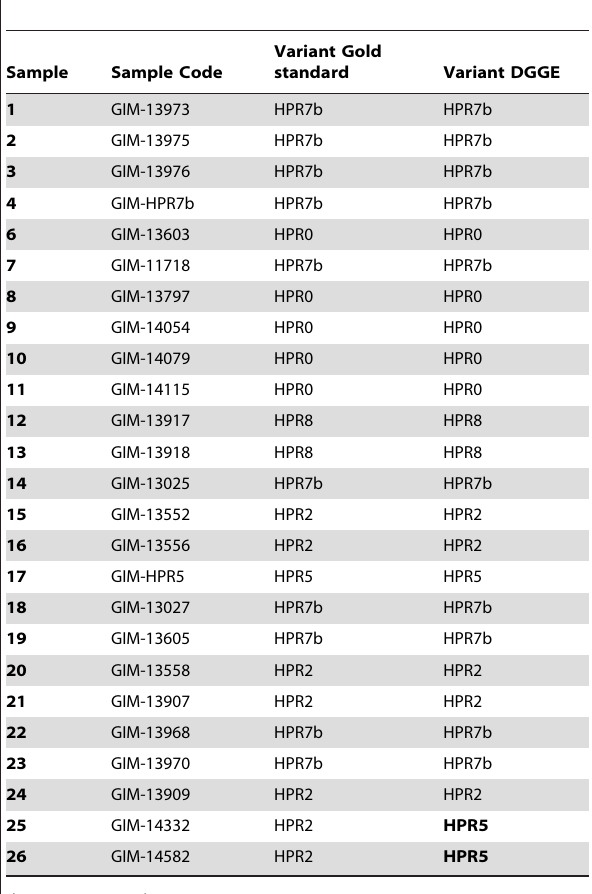
Table 2. Field samples analyzed and corresponding variants identified by sequencing (gold standard) and by DGGE.